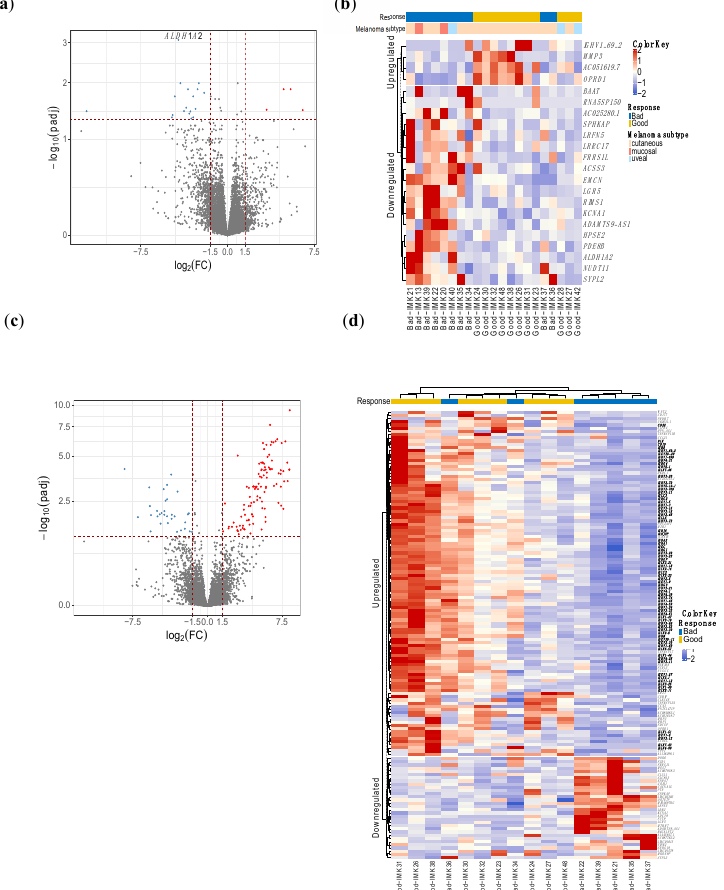
Figure 1. DE genes in responders of all types of melanomas and cutaneous melanomas. ( a ) an